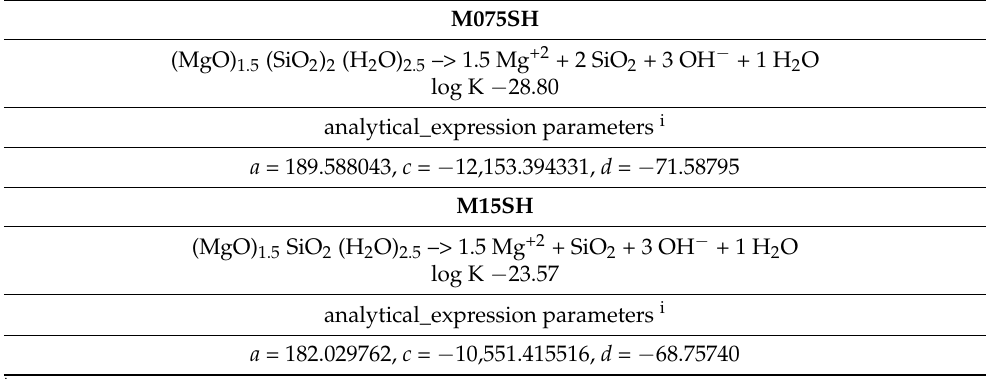
Table 4. MSH end-member properties [25].